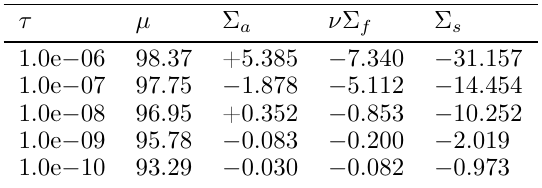
Table 13. Error on macroscopic cross sections after lossy compression by truncated HT on the MOX dataset with matrices M per reaction type